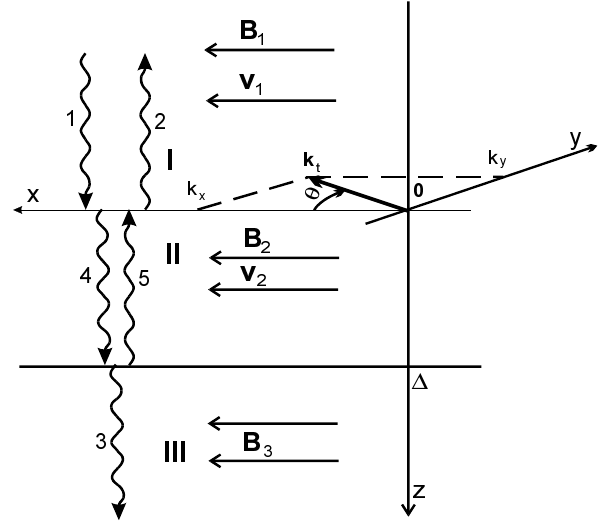
Fig. 1. Model of the medium and coordinate system. Roman nu- merals number the regions: I – solar wind, II – transition layer, III – magnetosphere. Arabic numerals number the waves: 1 – incident on the transition layer, 2 – reflected from the transition layer, 3 – transmitted to the magnetosphere, 4 – transmitted to the transition layer’s interior, 5 – reflected inside the transition